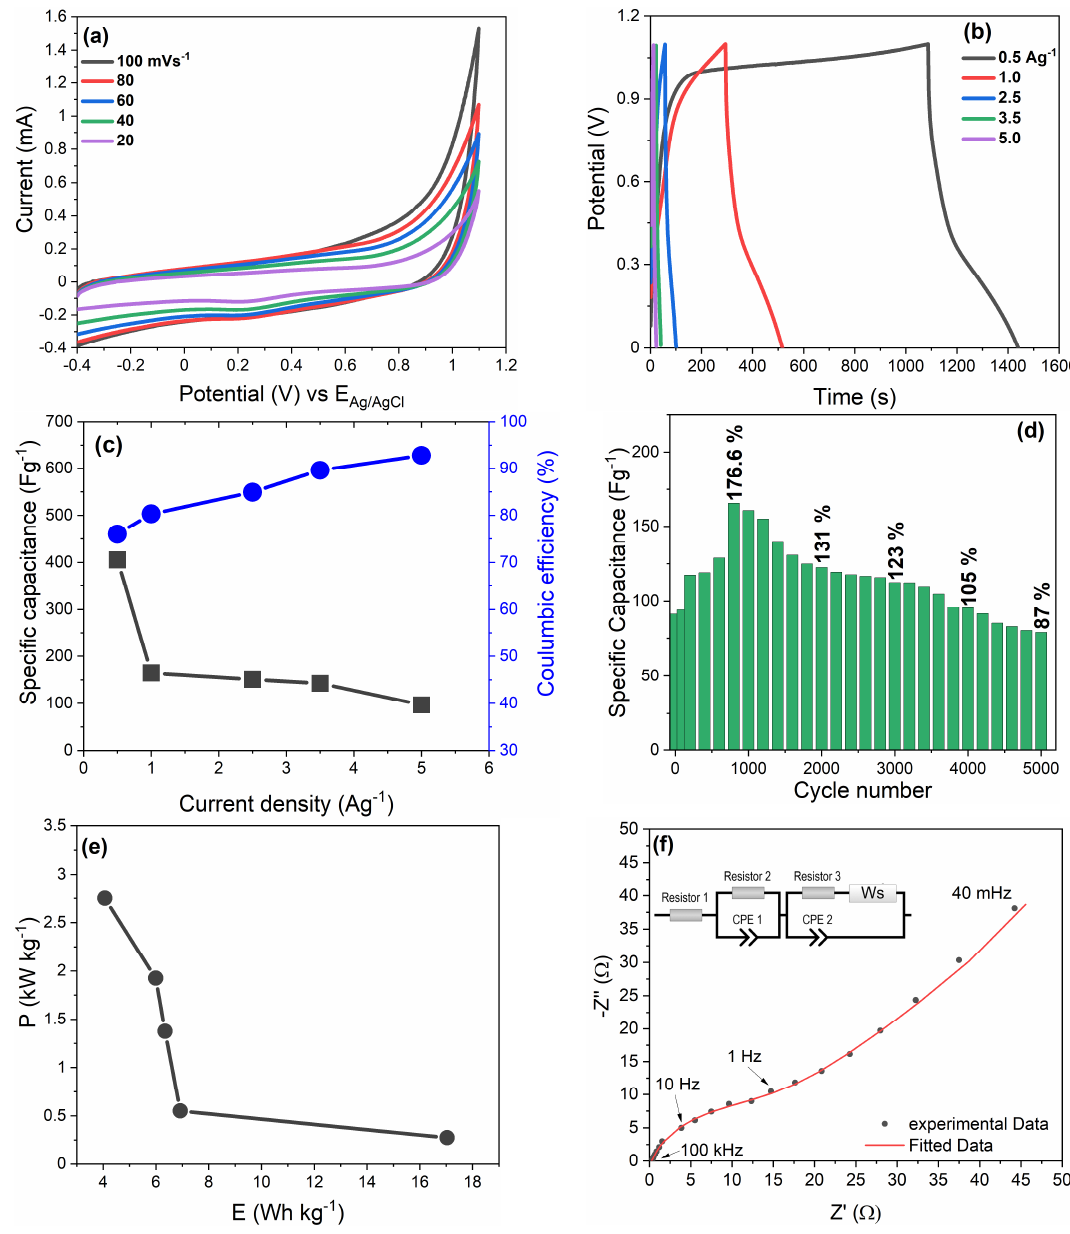
Figure 8. Electrochemical performance of Pbp@HD in two ‐ electrode configuration: ( a ) CV plots at various scan rates, ( b ) GCD plots at various current densities, ( c ) specific capacitance and coulombic efficiency as a function of current density, ( d ) cycle stability at 1 A g − 1 , ( e ) Ragone plot, and ( f ) EIS at E DC = 200 mV (Inset showing equivalent series circuit) for Pbp@HD.